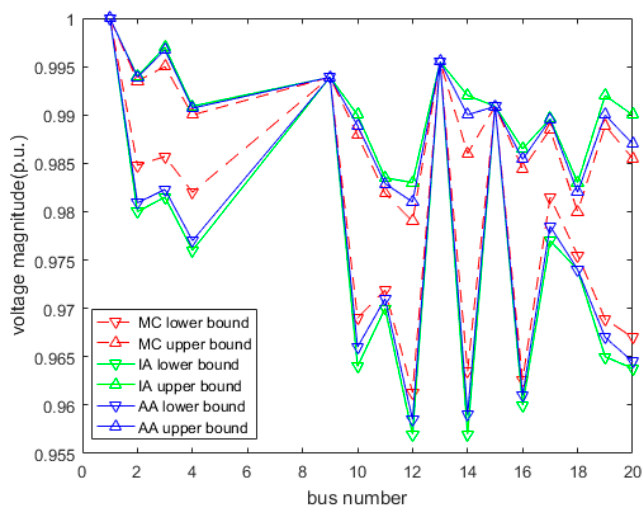
Figure 7. Bus voltage bounds for three different methods.